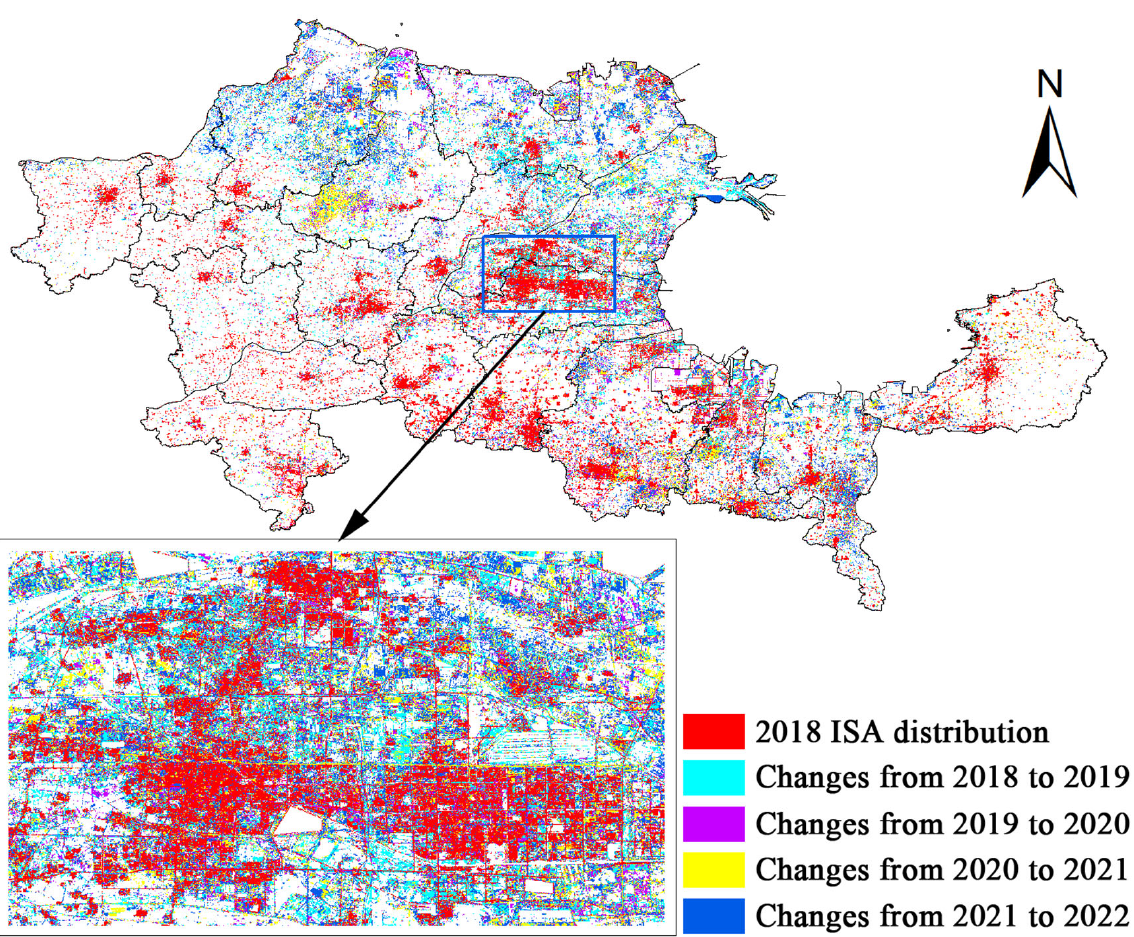
Figure 9. Spatial-temporal evolution of ISA in the last 5 Figure 9. Spatial ‐ temporal evolution of ISA in the last 5 years.